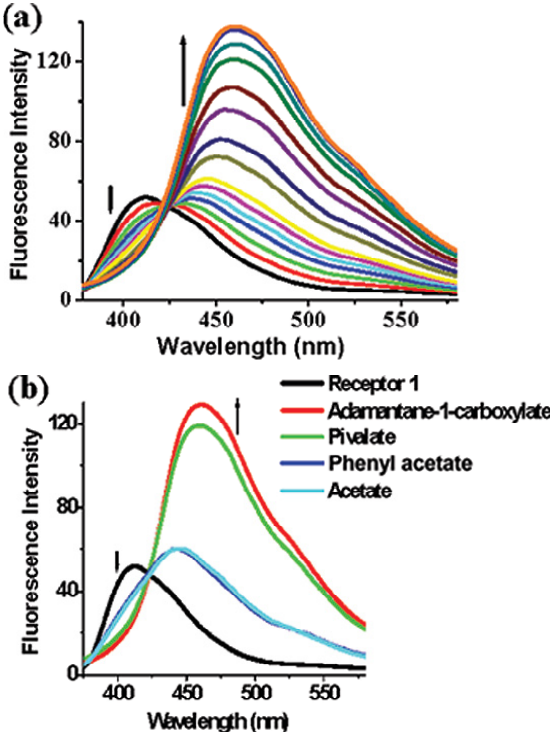
Figure 40. (a) Change of emission for 36 in the presence of increasing amounts of adamantane-1-carboxylate in CHCl Change of fluorescence intensity of 36 upon addition of different tetrabutylammonium carboxylates (8 equiv) with excitation at 356 nm. (adapted from 66(h).